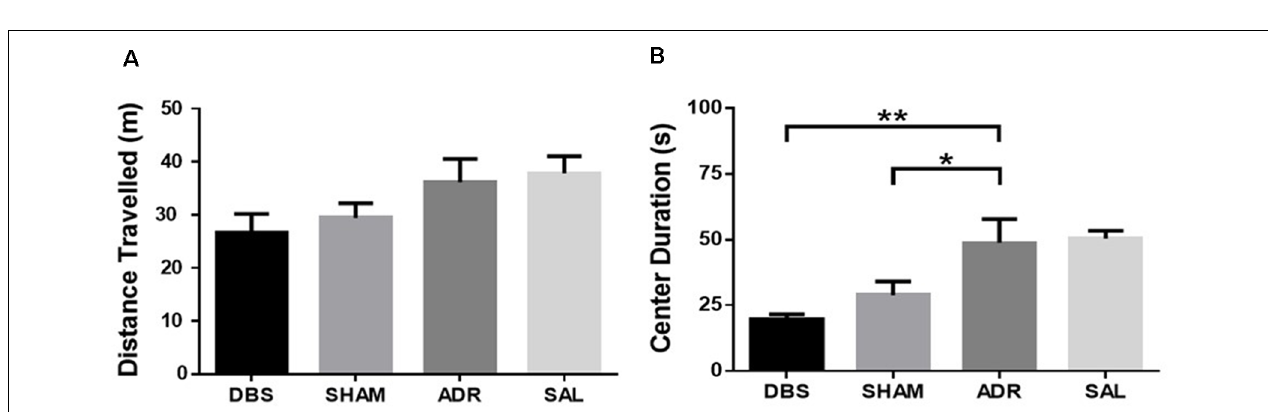
FIGURE 4 | Open field test (A) distance traveled and (B) time spent in the center region. Data shown in mean seconds ± standard error. Significance is illustrated as * p < 0.05; ** p < 0.01.